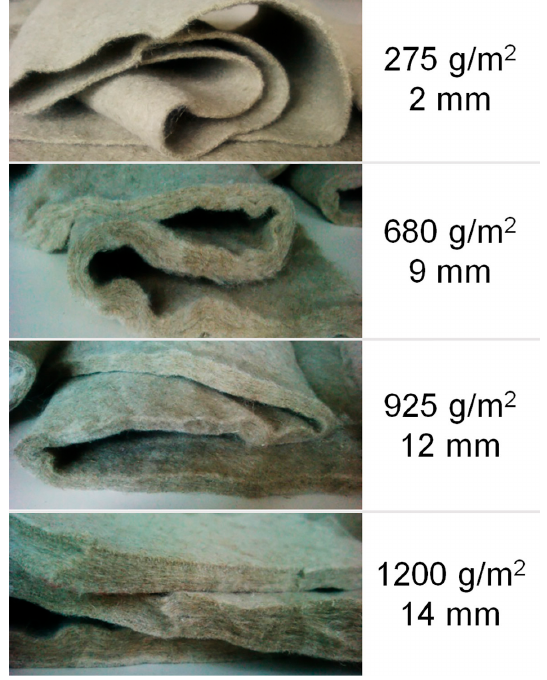
Figure 7. Photographic images of the nonwoven fabrics prepared.